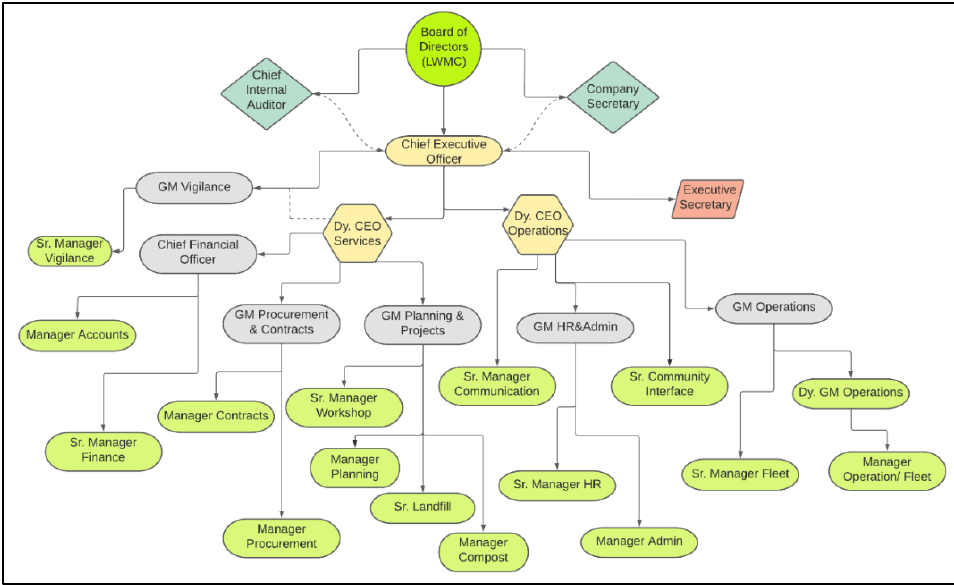
Figure 5. Administrative hierarch of LWMC .